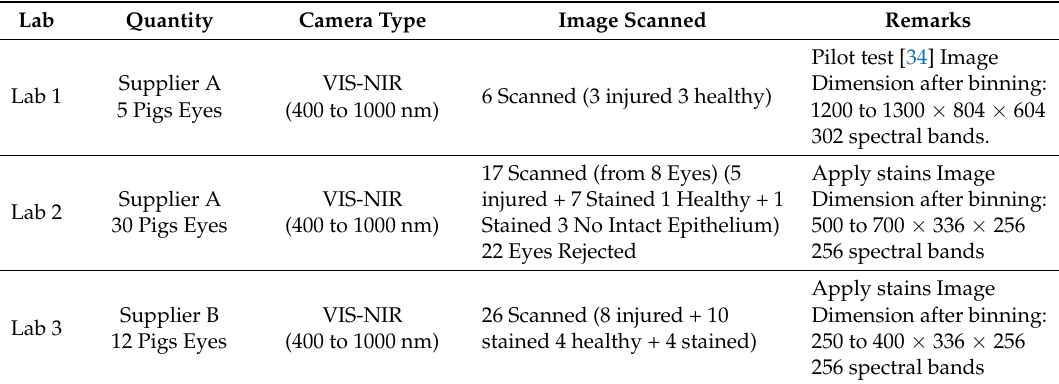
Table 1. List of experimental works.